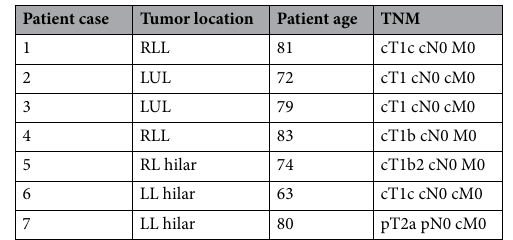
Table 1. Patient data RLL right lower lung, LUL left upper lung, RL right lung, LL left lung.